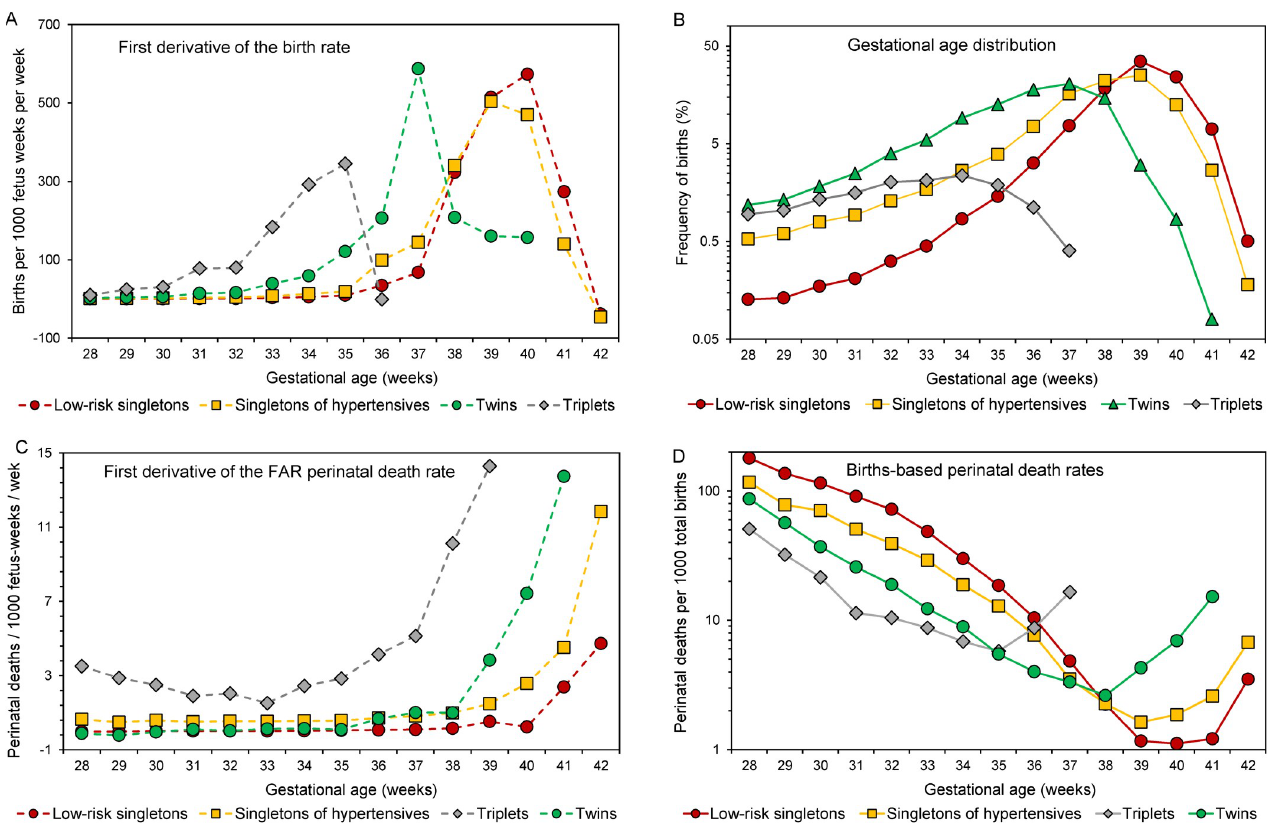
Fig 4. The first derivative of the birth rate (Panel A), the gestational age distribution (Panel B), the first derivative of the fetuses-at-risk perinatal death rate (Panel C), and births-based gestational age-specific perinatal death rates (Panel D), among 4 low- and high-risk cohorts, United States, 2004–2015.